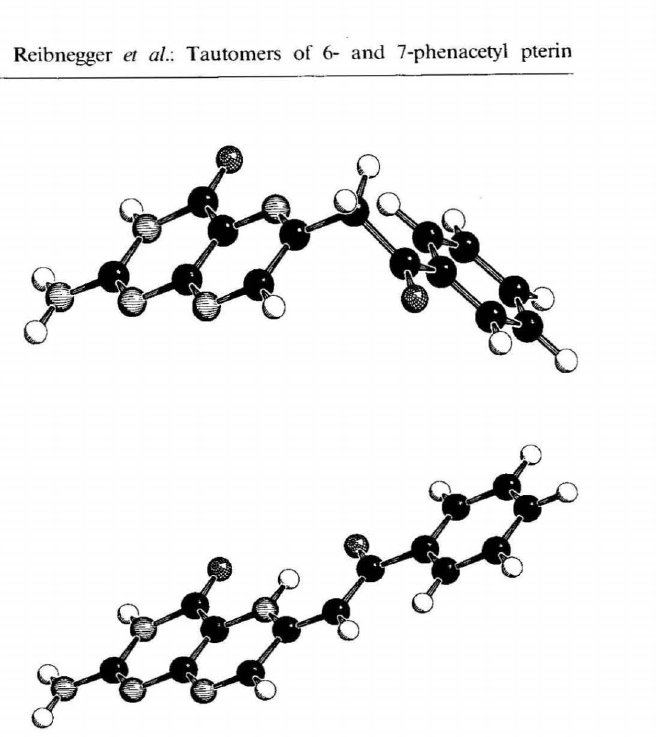
hgure I. Optimized geometries of both the keto form (upper molecule) and the vinylogous amide form (lower molecule) of 6-phenacetyl pterin, obtained by ab initio calculation using the 3-2IG* basis set.